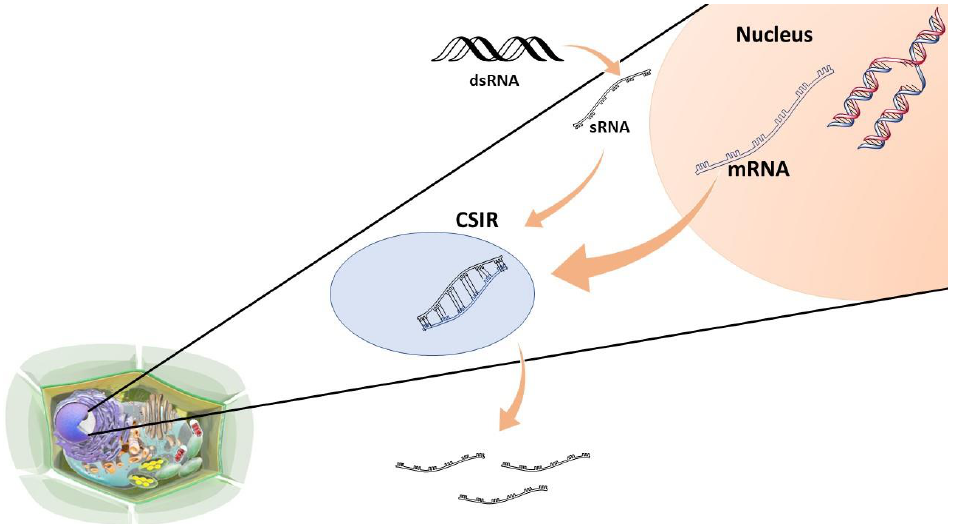
Figure 6. Graphical summary of cellular RNAi silencing in the mRNA target. The cell generates RNAi (sRNA) from the degradation of dsRNA. A guide chain of RNAi is incorporated into the RISC that subsequently binds to an mRNA complementary sequence, leading to degradation [159].